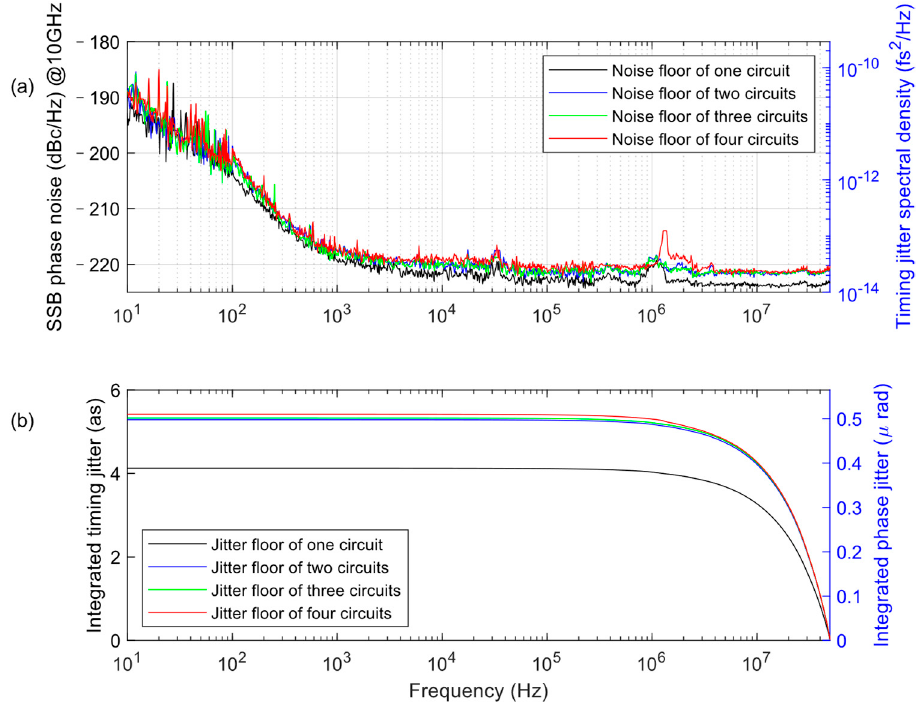
Figure 7. Noise floors ( a ) and integrated timing jitters ( b ) of discriminator circuits. The black lines are the results of a single circuit. Blue, green, and red lines are the results when 2, 3, and 4 circuits are added separately.